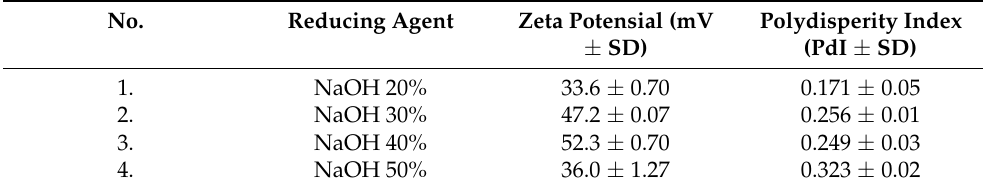
Table 4. Zetasizer nano analysis of AgNP-chi-spheres. The zeta potential and PI values were performed in